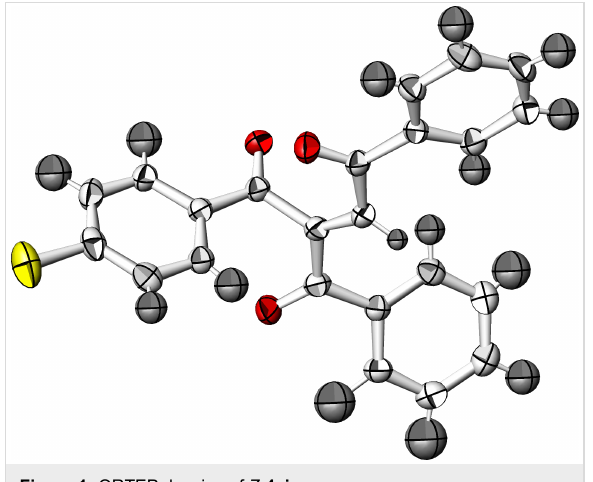
Figure 1: ORTEP drawing of Z - 4ai